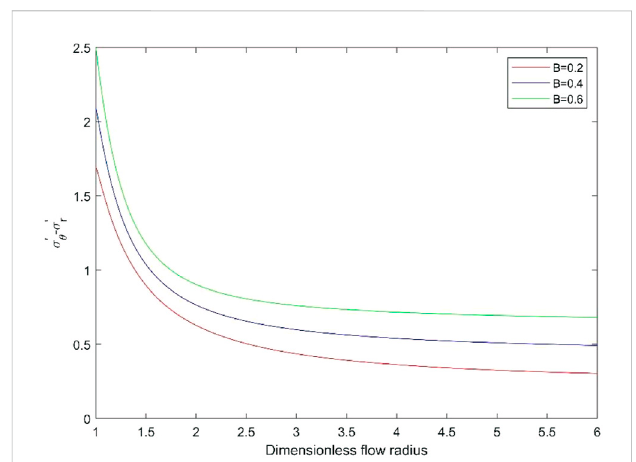
FIGURE 6 Difference between effective circumferential stress and effective radial stress in the acceleration fl ow for various